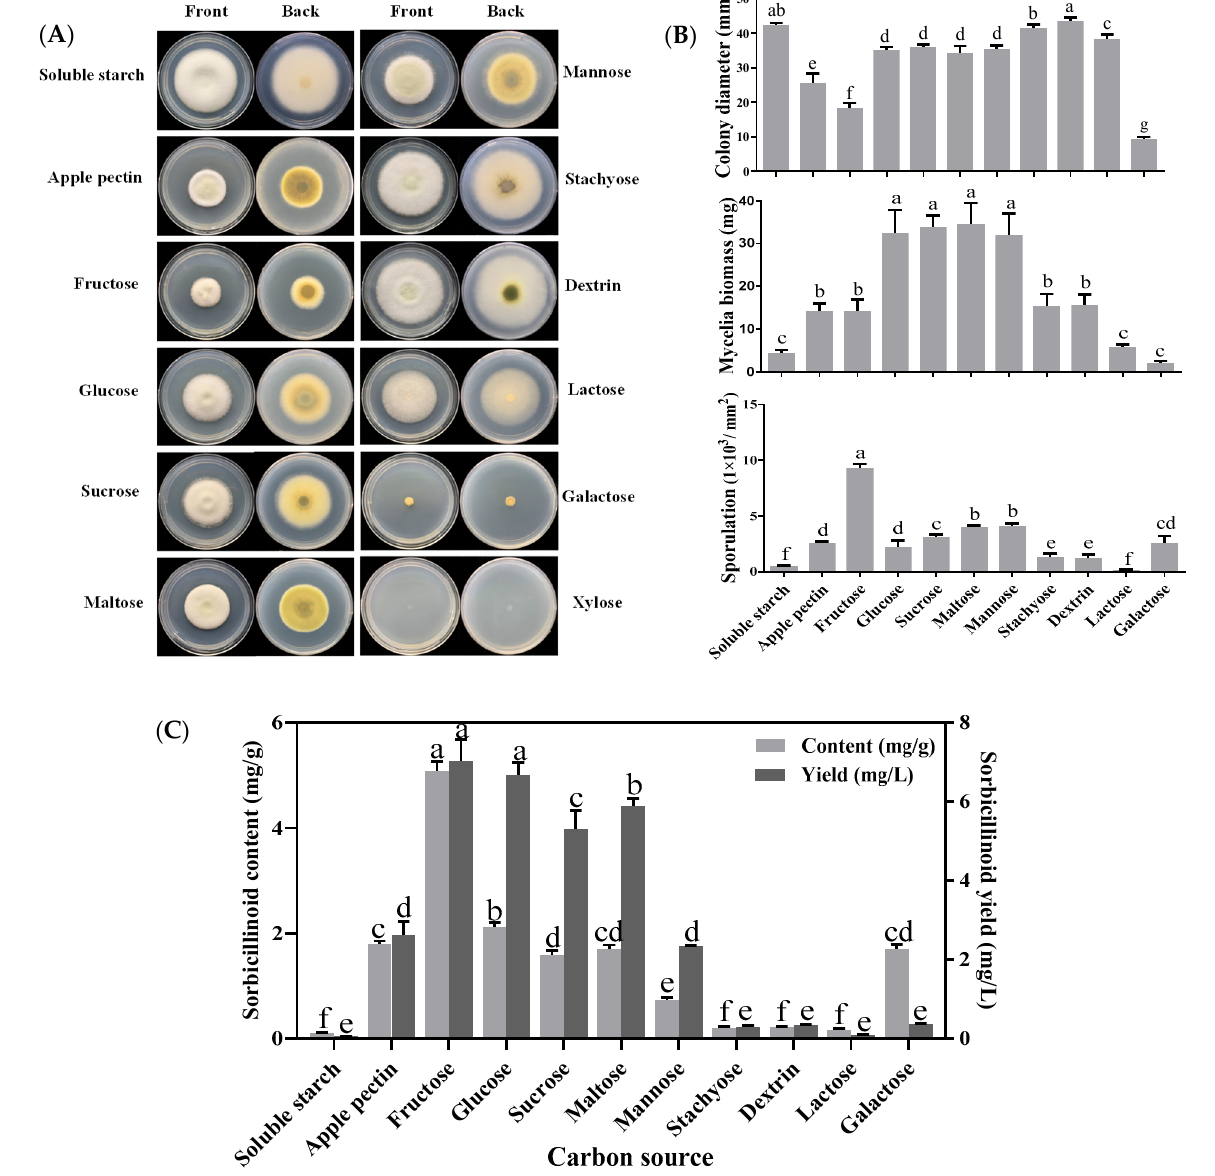
Figure 1. Effects of different carbon sources on colony extension, mycelial growth, sporulation and sorbicillinoid production of U. virens . ( A ) Colony morphology of U. virens, cultured for 18 days at 28 ◦ C on PB medium, supplemented with different carbon sources; ( B ) Effects of different carbon sources on colony diameter, mycelial biomass and sporulation of U. virens ; ( C ) Effects of different carbon sources on sorbicillinoid content (mg/g) and yield (mg/L). Bars represent standard deviations of the means. Different letters in each figure mean significant differences according to Duncan’s Multiple Range Test ( p < 0.05).